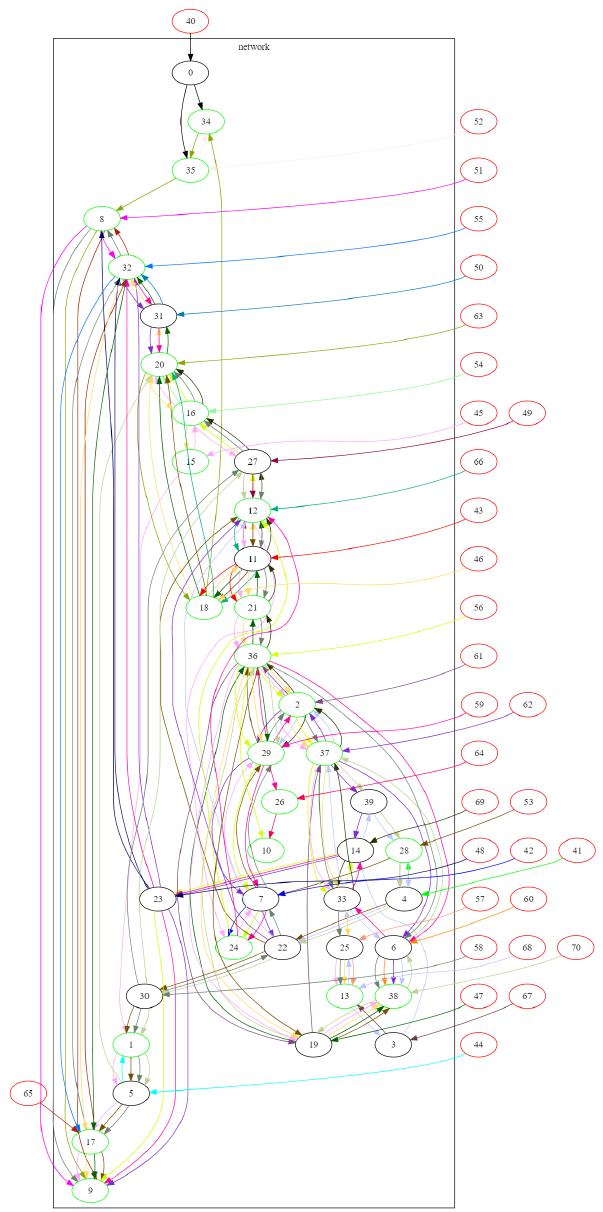
Figure 9. Result on use case res7 using the Lagrangian